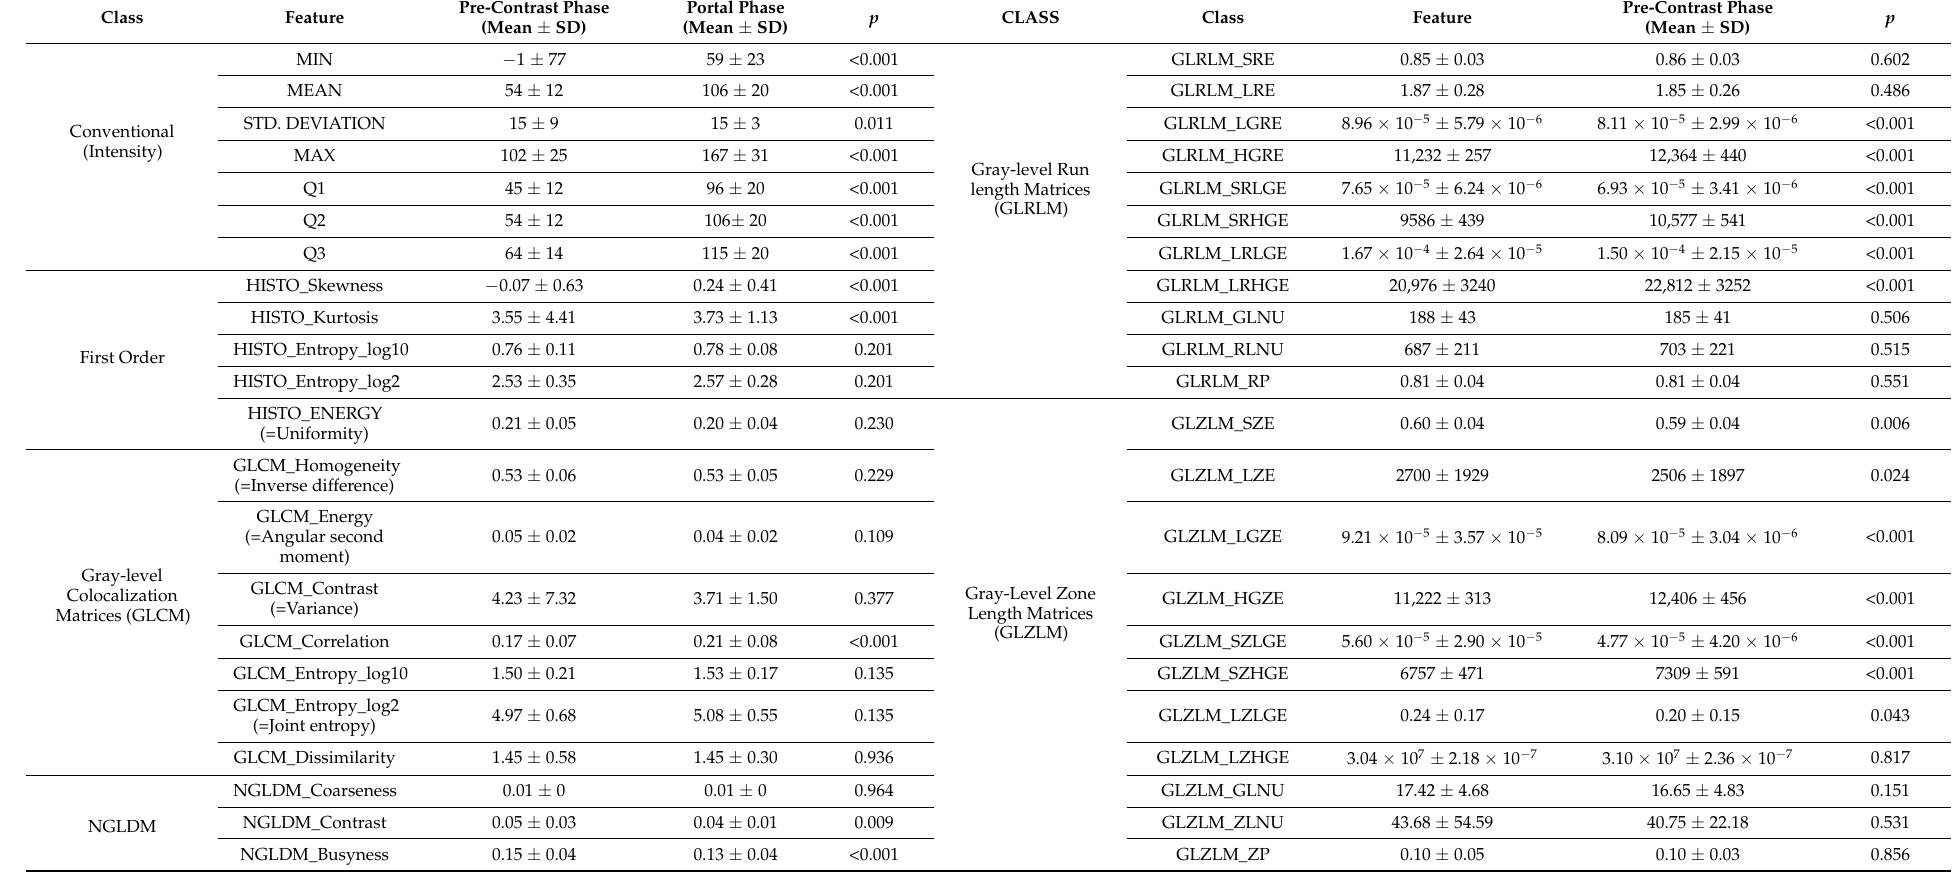
Table 4. Values of the radiomics features of Liver volume of interest (VOI) in the portal and pre-contrast